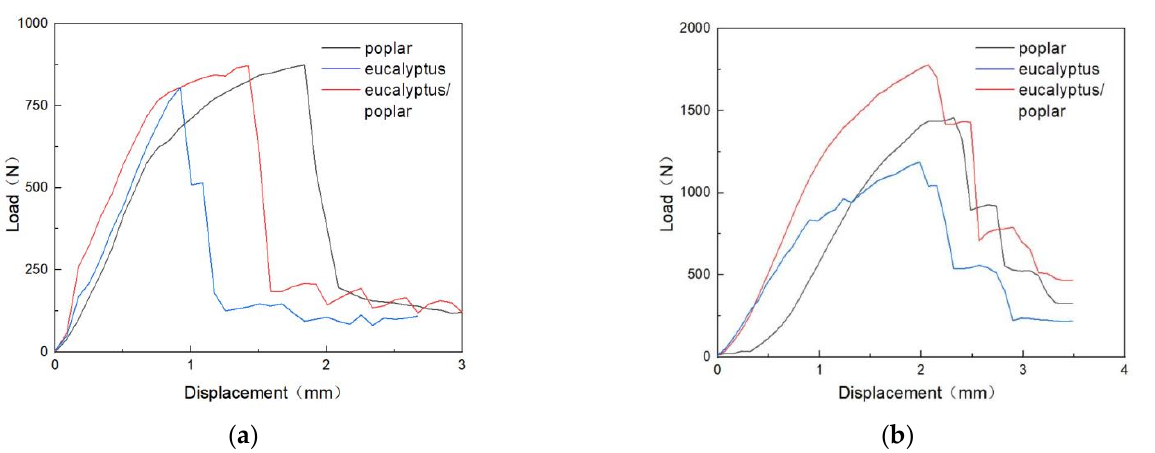
Figure 5. Three kinds of plywood load–displacement curves: ( a ) one staple; and ( b ) four staples.